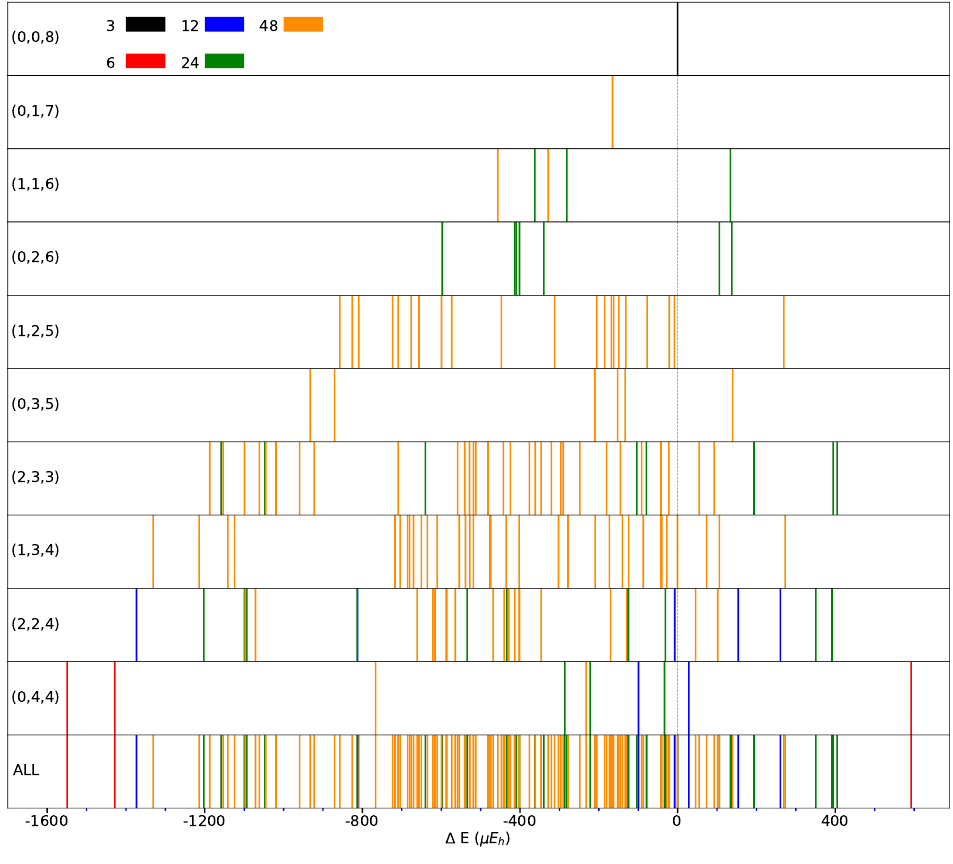
Figure 5. Distribution of the SICs as a function of the energy difference with respect to the REF case (indicated by the vertical dashed line) for CECs (Classes of Equivalent Composition) accessible using the S222 supercell. CEC’ representative composition is indicated in each panel (left). Panel “ALL” shows all the 162 SICs resulting from the 10 CECs. Different colors indicate different multiplicities. B3LYP energy in E h per two f.u. (For interpretation of the reference to colors in this figure legend, the reader is referred to the web version of this